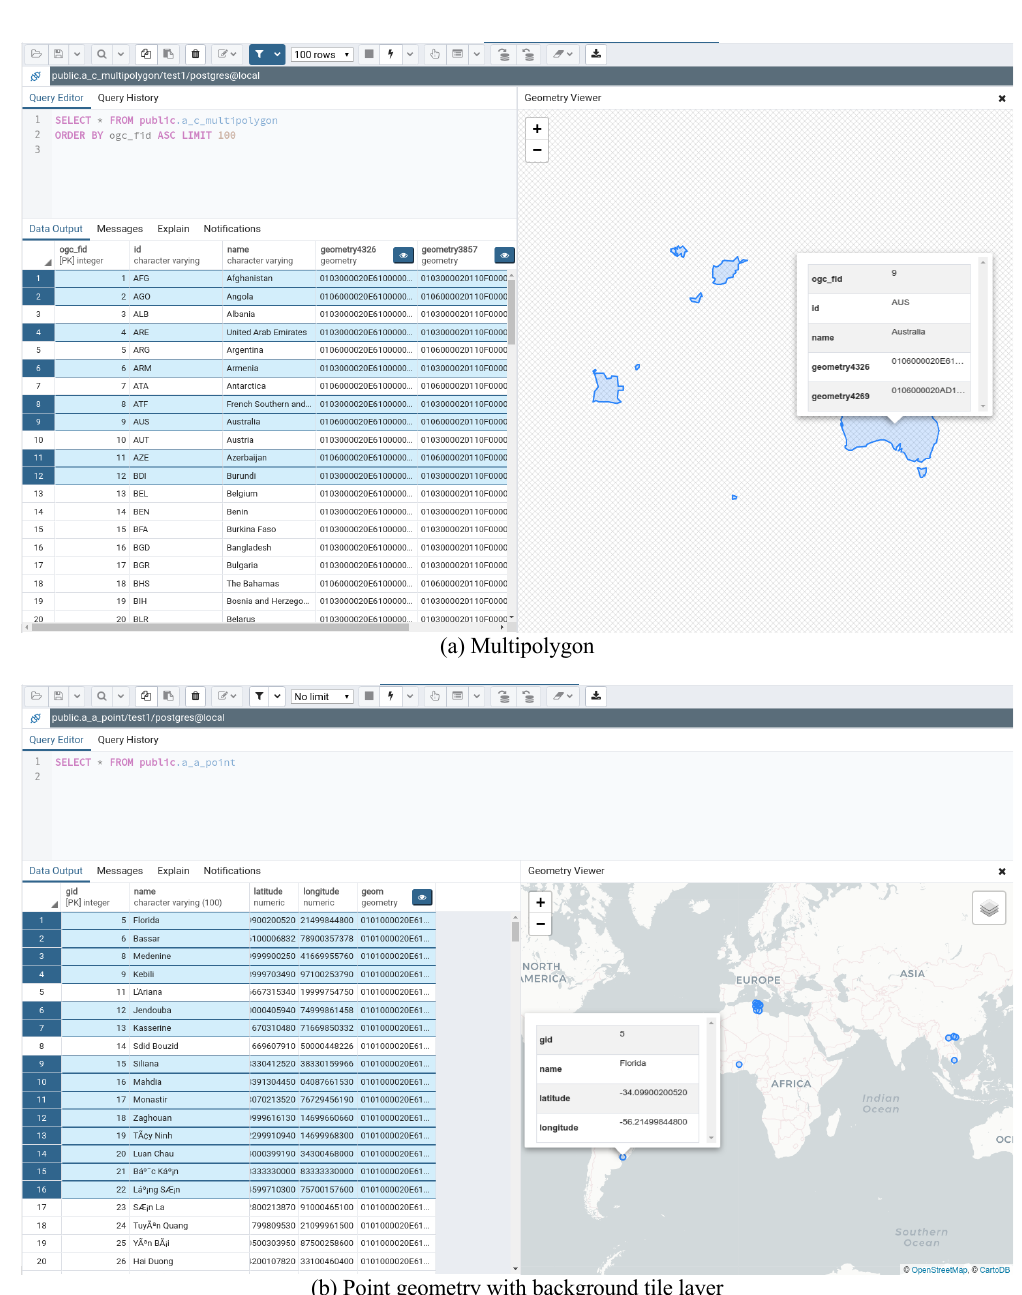
Figure 4: The result of geometry